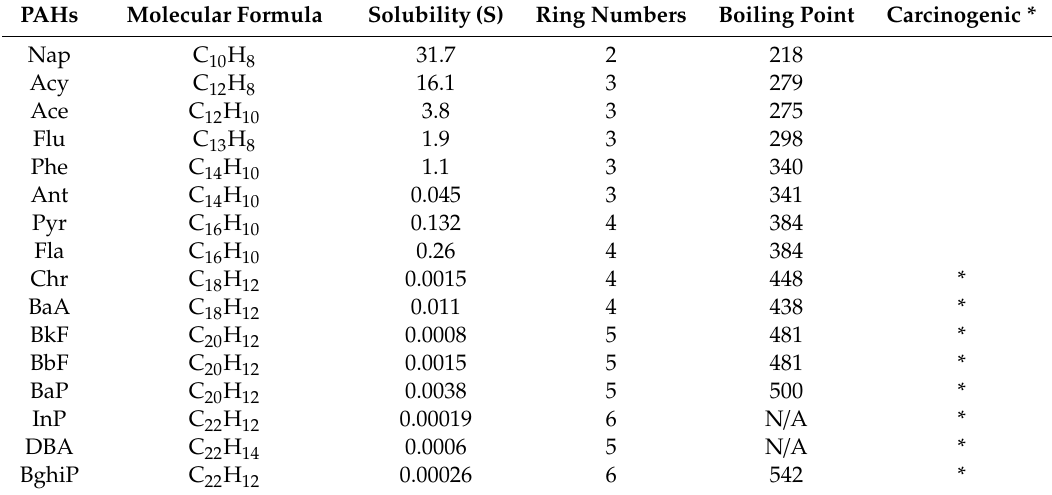
Table A1. Physical and chemical properties of 16 PAHs.